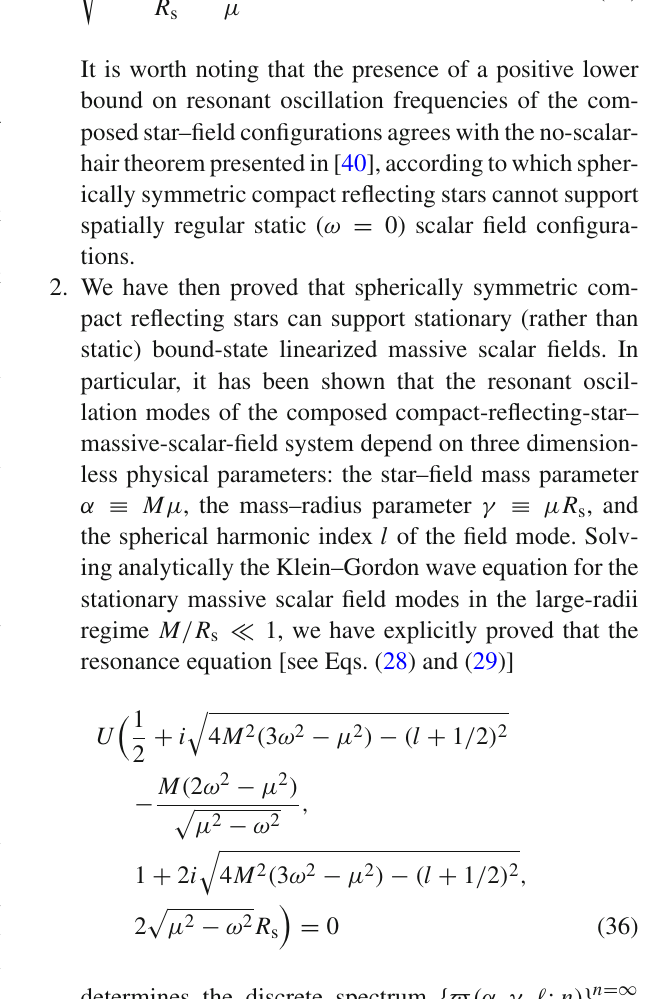
Table 4 Resonant oscillation frequencies of the composed stationary compact-reflecting-star–linearized-massive-scalar-field configurations with α = 1 ,γ = 10, and l = 0. We display the resonant oscillation fre- quencies (cid:16) analytical ( n ; α,γ,(cid:14)) ofthestationaryscalarfieldsasobtained from the analytically derived resonance equation (34) in the asymp- toticregime(31)ofmarginally-boundstar–fieldconfigurations.Wealso present the corresponding numerically computed resonant oscillation